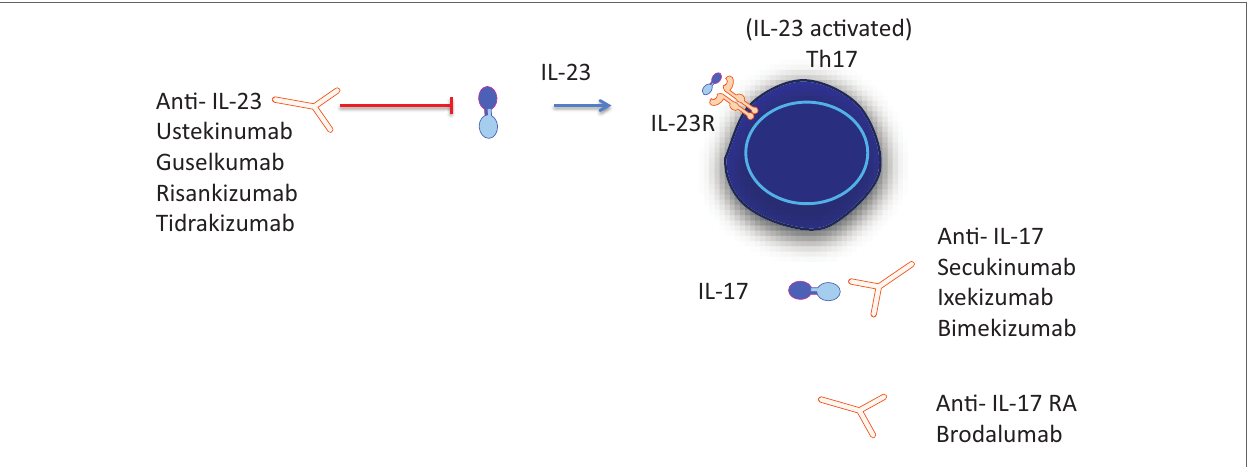
FIGURE 1 | IL-23/IL-17 axis is the focus of novel treatments targeting either cytokine or cytokine